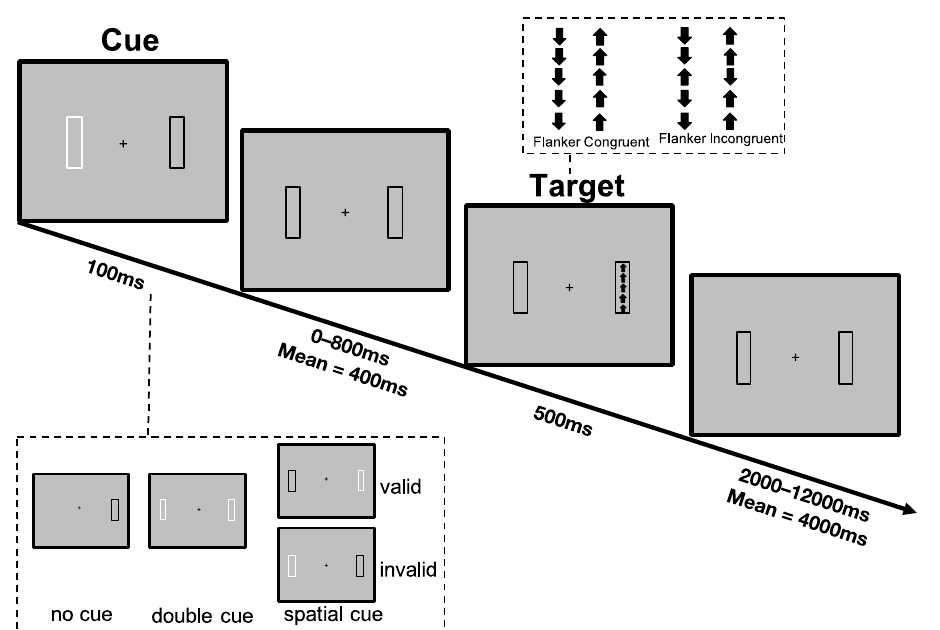
Figure 1. Sequence of events in an invalid cue/congruent trial as implemented by the Lateralized Attention Network Test-Revised (LANT-R) [29,44].